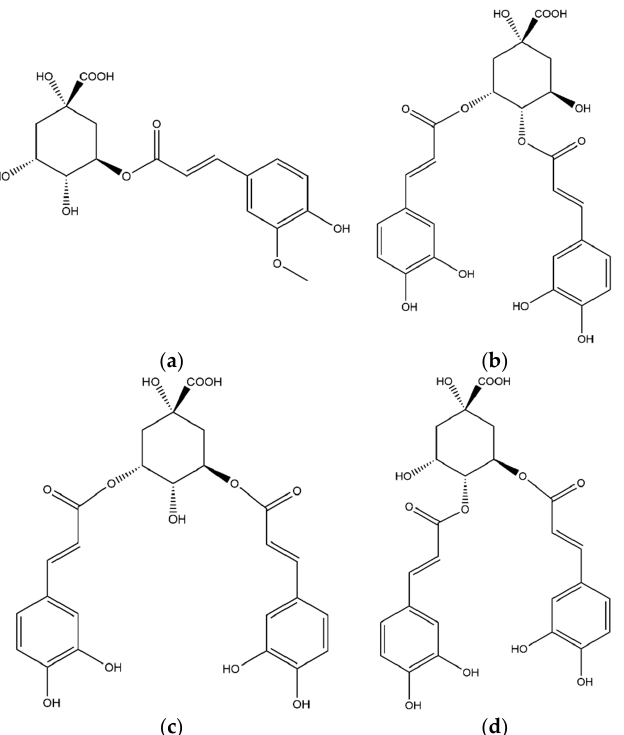
Figure 6. Structures of the chlorogenic acids identified in the coffee leaf extract: ( a ) 5-feruloyl-quinic acid, ( b ) 3,4-dicaffeoyl-quinic acid, ( c ) 3,5-dicaffeoyl-quinic acid, ( d ) 4,5-dicaffeoyl-quinic acid.